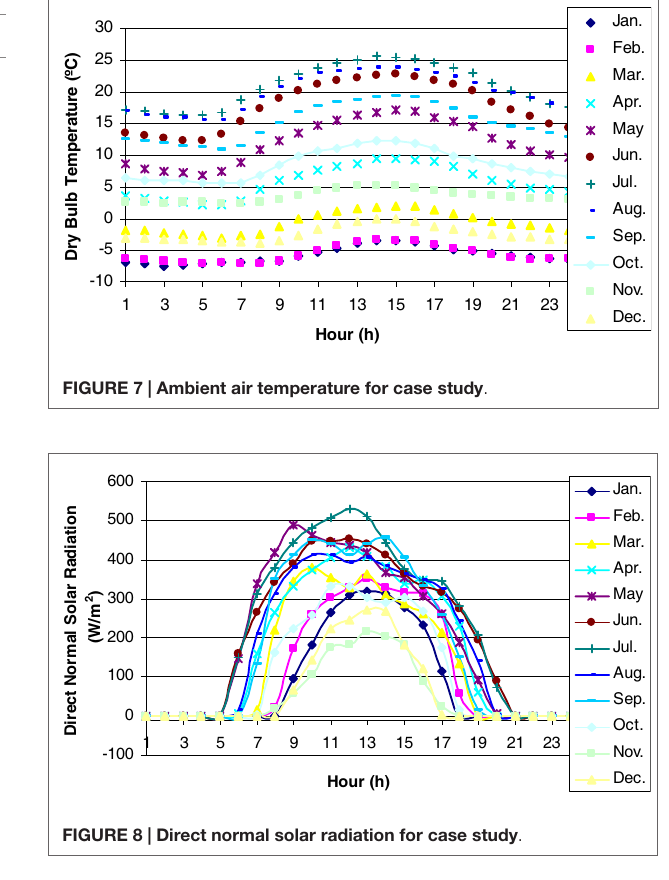
TaBle 4 | input parameters for the computer model.